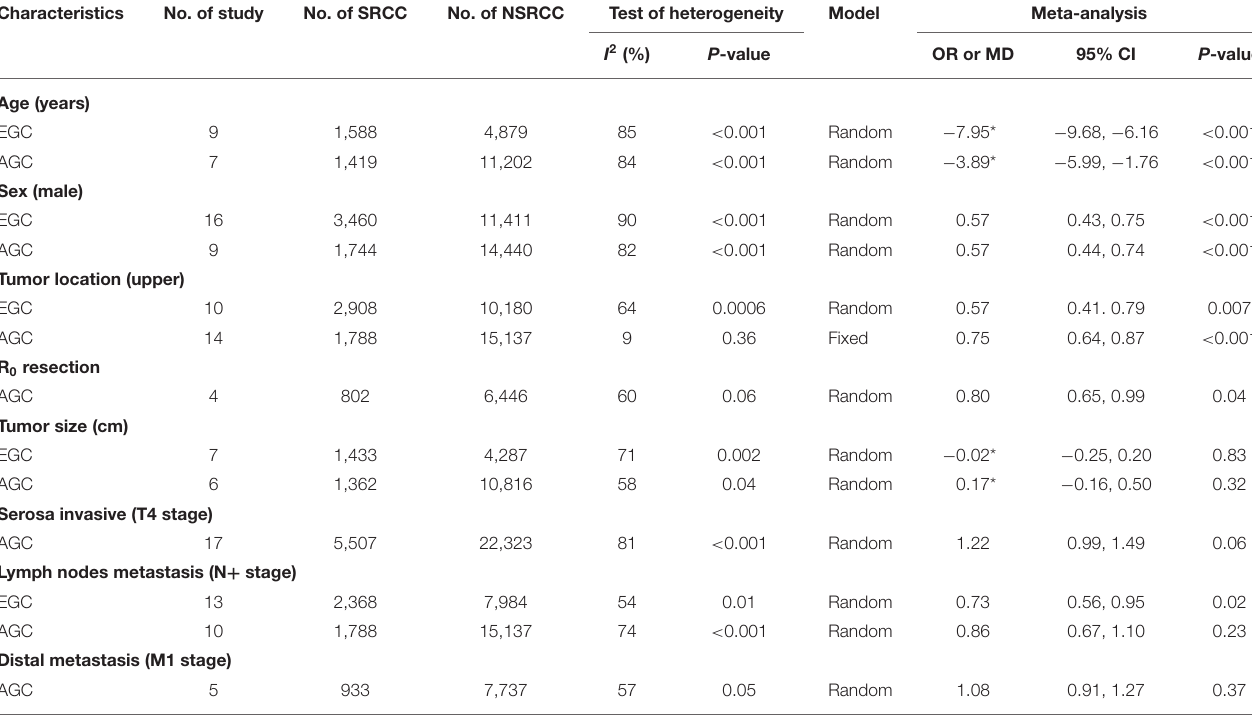
TABLE 3 | The meta-analysis of clinicopathological characteristics between SRCC and NSRCC patients based on tumor stage (EGC and AGC).